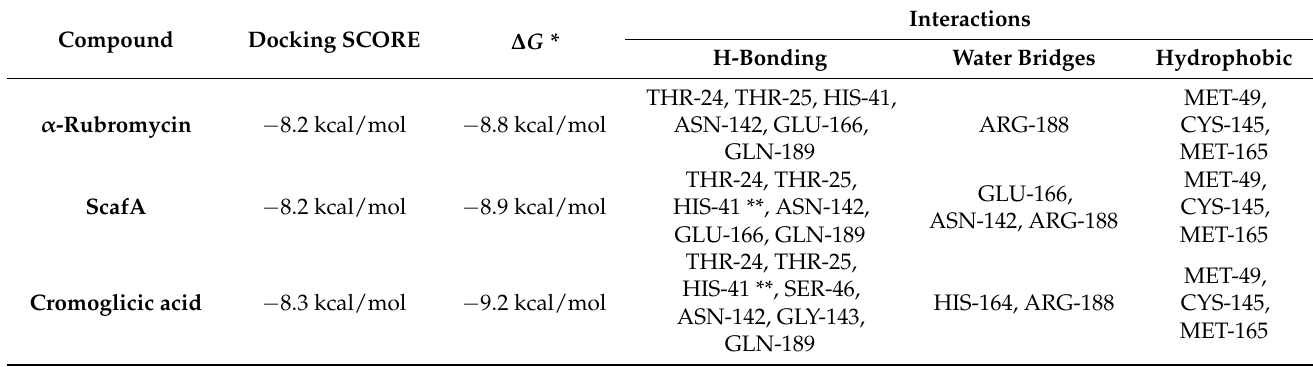
Figure 4. Binding modes of ( A ) α -rubromycin, ( B ) ScafA, and ( C ) cromoglicic acid inside the M Pro active site. ( D ) RMSDs of their docking pose over 200 ns of MDS. Table 1. Docking scores and ∆ G s of α -rubromycin, ScafA, and cromoglicic acid, along with their interactions inside the M Pro active